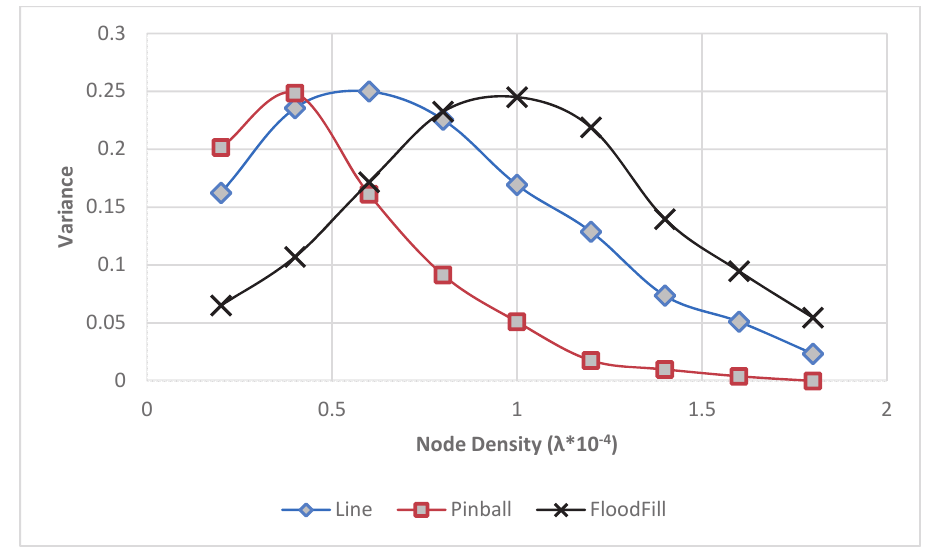
Figure 8. The variances of the intruder’s escape probability ( P intru ) of an intruder that adopts the linear, pinball and flood-fill algorithms in a WSN with varying node densities λ